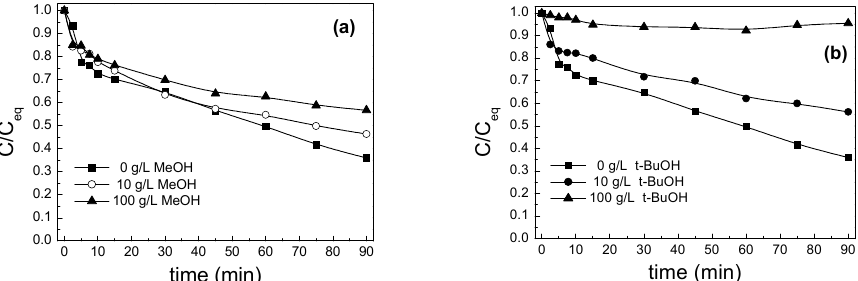
Figure 13. E ff ect of methanol ( a ) and t -butanol ( b ) on 500 µ g / L SMX degradation with 200 mg / L biochar Figure 13. Effect of methanol ( a ) and t ‐ butanol ( b ) on 500 μ g/L SMX degradation with 200 mg/L and 1000 mg / L SPS in UPW and inherent biochar and 1000 mg/L SPS in UPW and inherent pH.